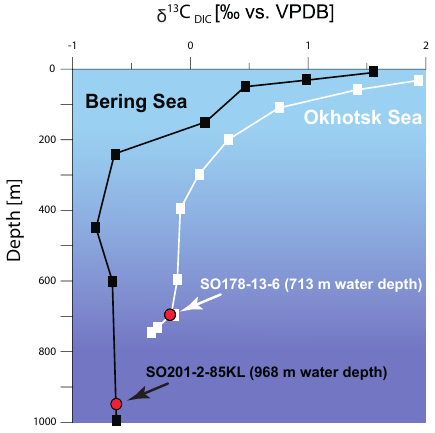
Fig. 3. Water column profiles of δ 13 C DIC in the Bering Sea (station SO201-2-67) and Okhotsk Sea (station LV29-84-3). Black curve with squares indicating sampled depth intervals given as δ 13 C DIC profile of the Bering Sea together with the respective depth-interval of SO201-2-85KL (red spot). White curve with squares indicating sampled depth intervals of δ 13 C DIC profile for the Okhotsk Sea to- gether with the corresponding depth-interval of SO178-13-6 (red